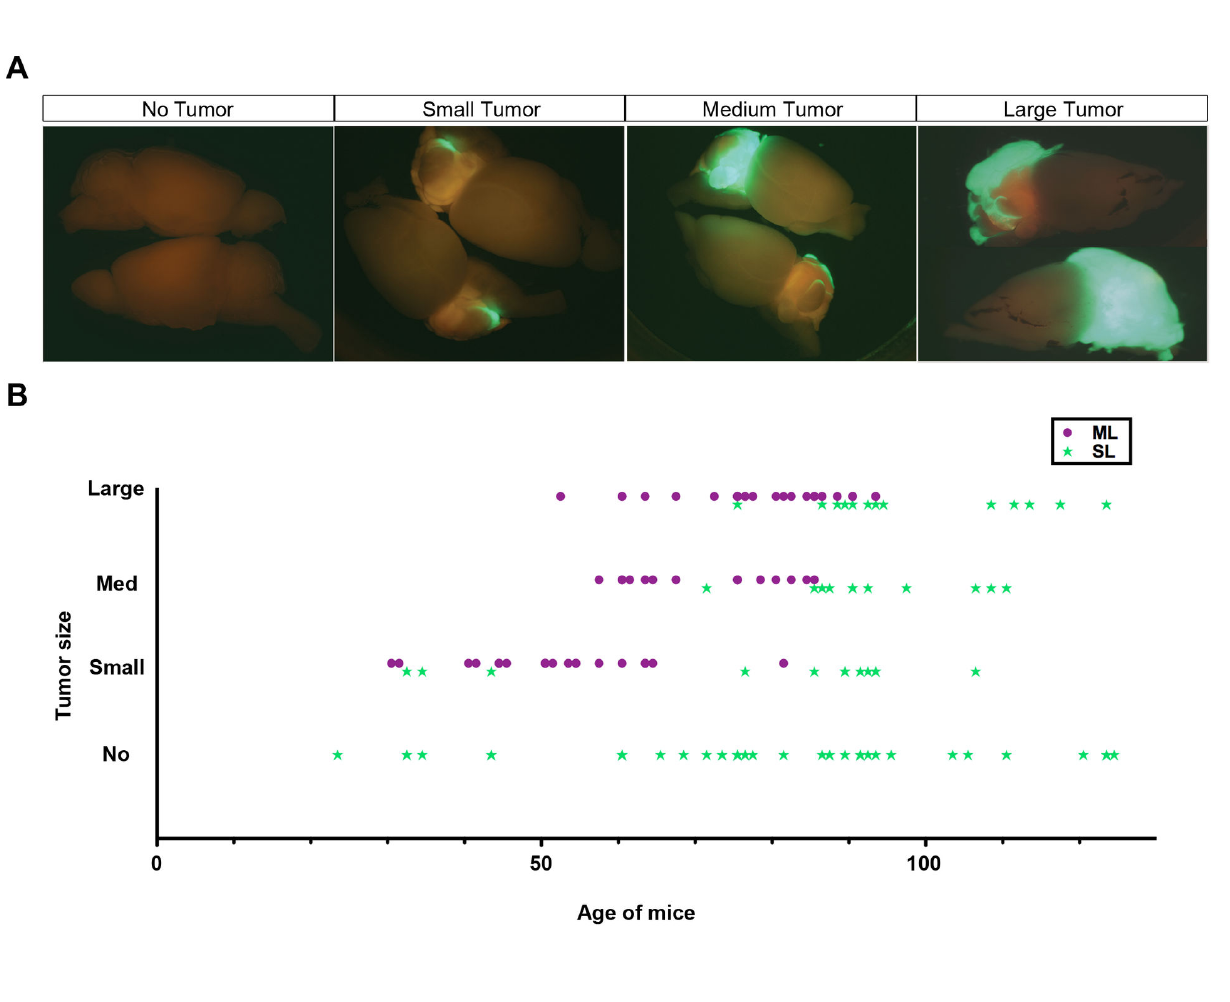
Figure 7. MADM-ML medulloblastoma model generates tumors at full penetrance with a more consistent timeline of tumor progression. (A) Representative images used for scoring tumor size and penetrance. (B) Summary of different tumor sizes in MADM-SL (green stars) and MADM-ML (purple dots) models at various ages. MADM-SL does not have a predictable tumor progression time course and has less than 40% tumor penetrance even after P75. Conversely, MADM-ML has a relatively consistent timeline of tumor progression and full